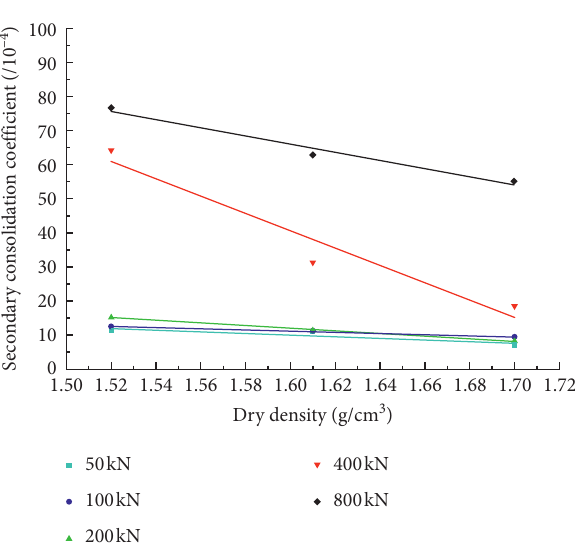
Figure 10: The relationship between dry density and secondary consolidation